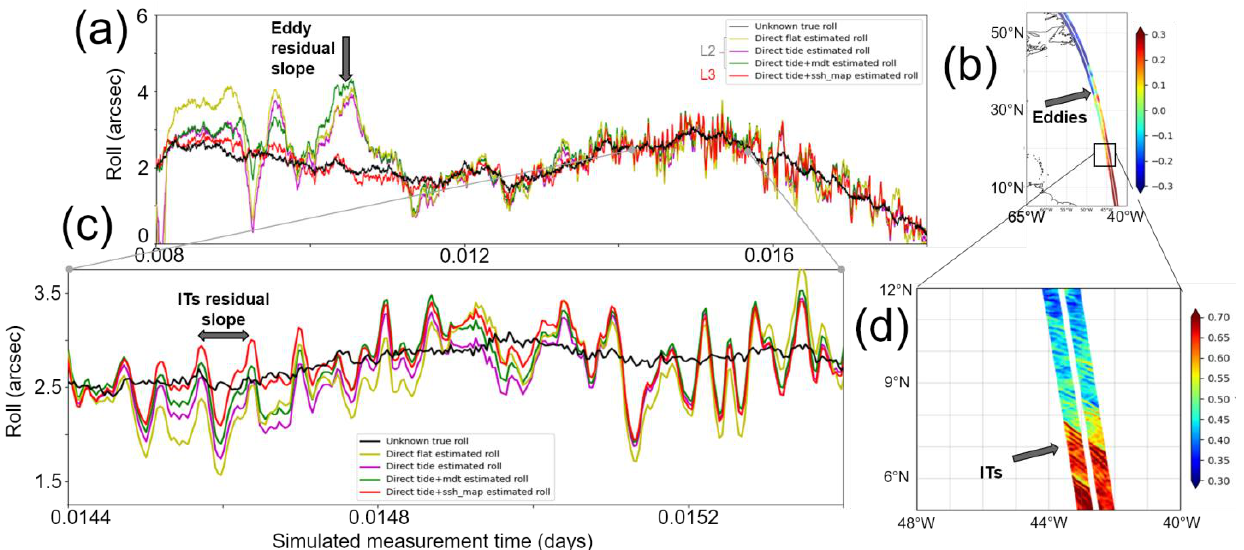
Figure 12. Example of direct method in the Level-3 algorithm based on the MITgcm model. Panel ( a ) shows the along-track roll values (in arcsec) as a function of time (in days) for the arbitrary pass of panel ( b ). Panels ( c ) and ( d ) are the same as ( a ) and ( b ) for a zoom located in the Tropical Atlantic. The black line of panels ( a ) and ( c ) is the true error (unknown) to calibrate. The colored lines are the calibration outputs for the Direct method when using different priors: yellow is for a flat SSH-MSS (no tides correction), purple is for a static barotropic tides model, green is for a tides model plus static mean dynamic topography model, and red is for a multi-mission dynamic SSHA